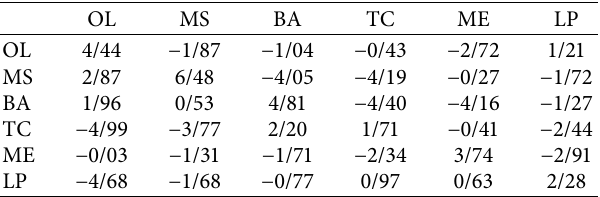
Table 9: Defuzzification of fuzzy total